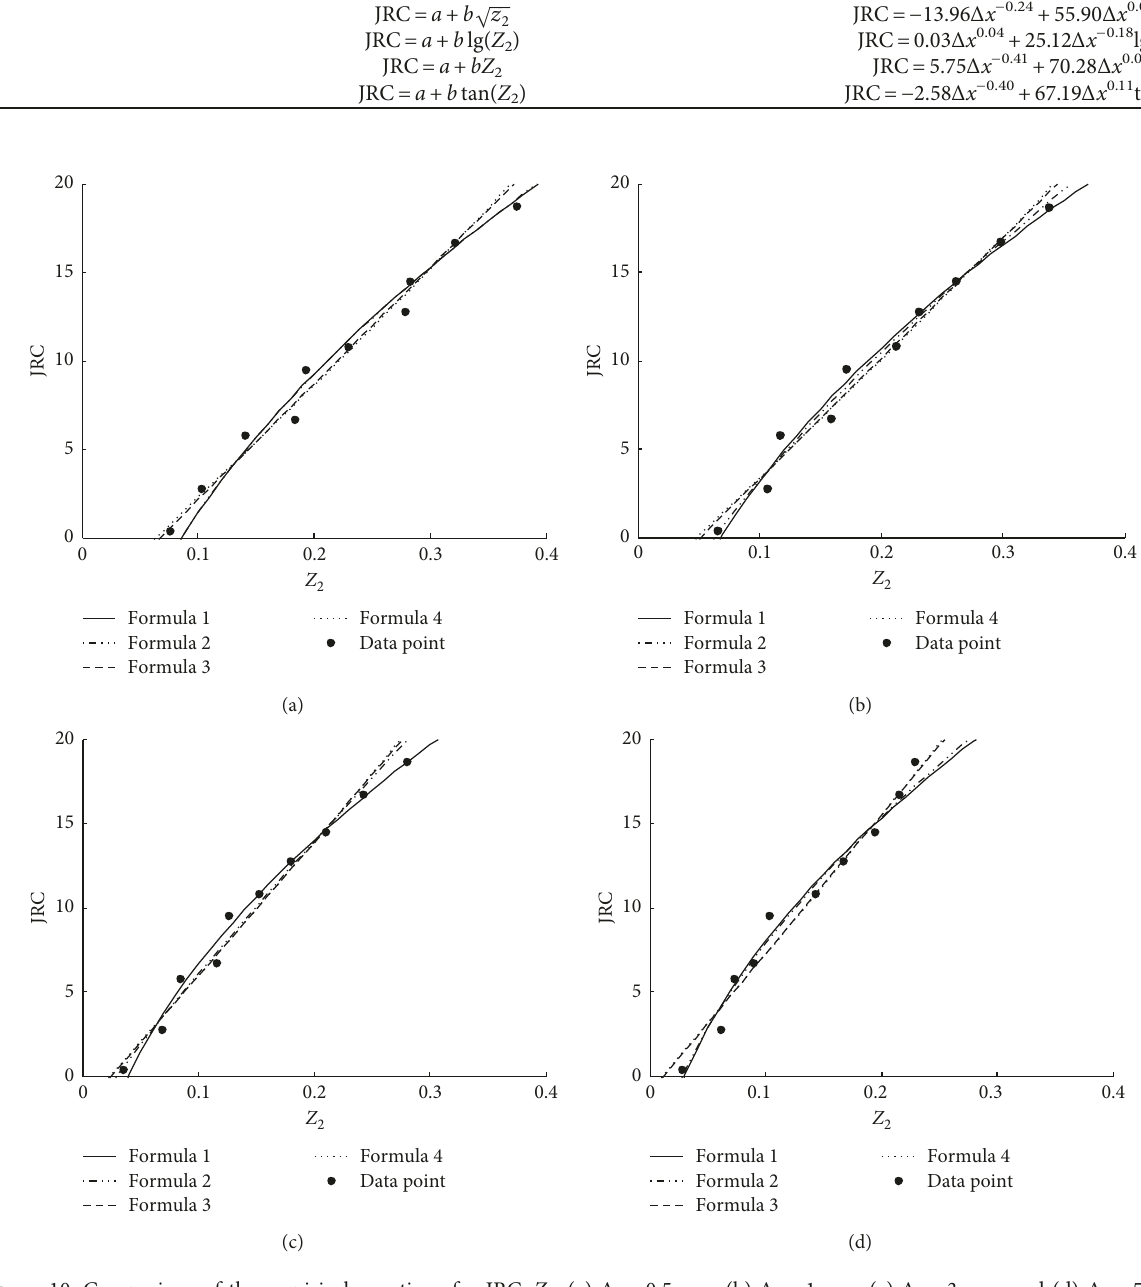
� 0.5mm, (b) Δ x � 1mm, (c) Δ x � 3mm, and (d) Δ x � 5mm. 2 : (a) Δ x